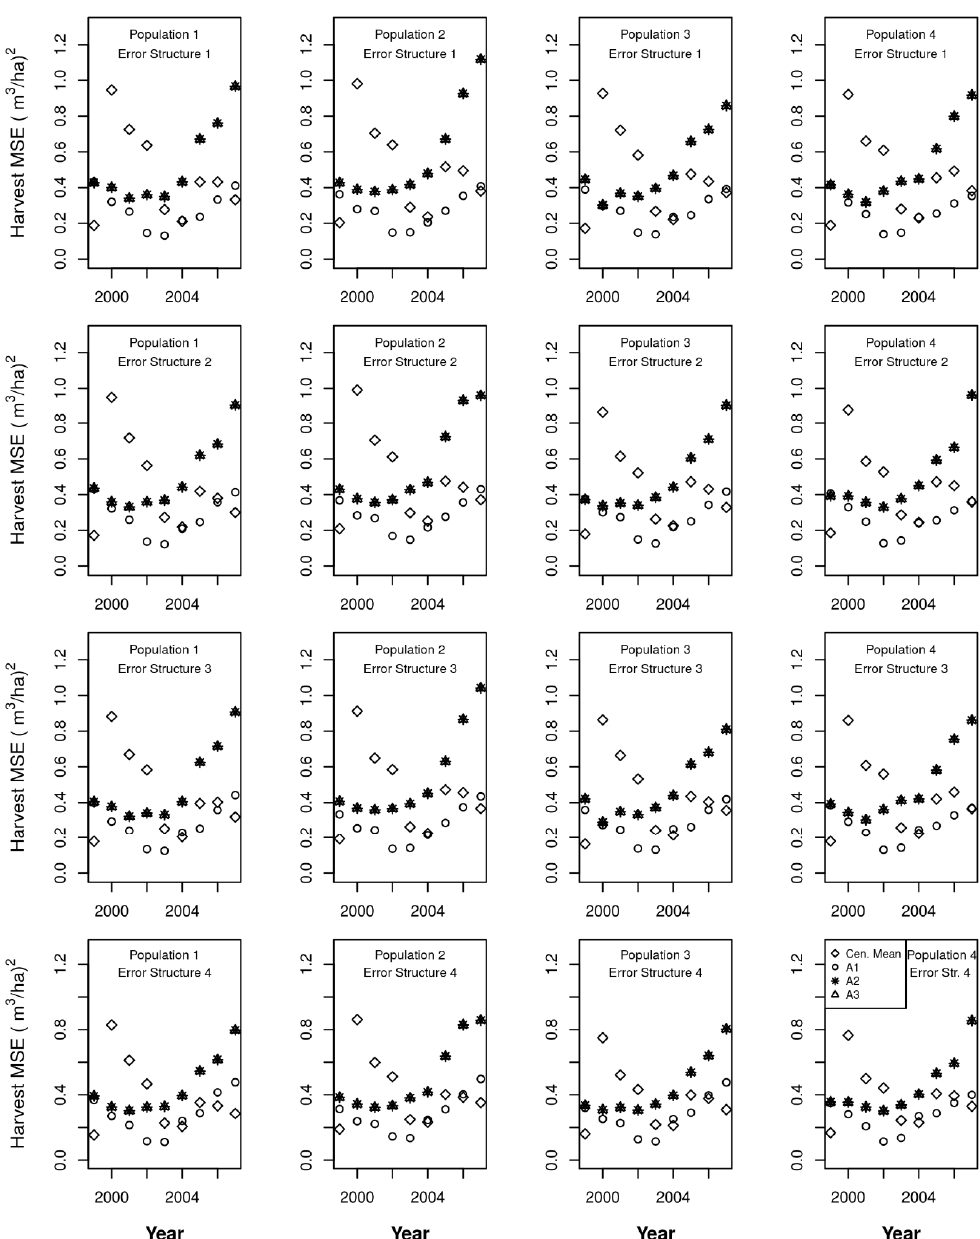
Figure 3. The means of the harvest estimators under A1, A2, and A3 and the centralized mean estimator relative to the population mean for harvest, over 1000 iterations of 1000 samples for each population and sample error structure.